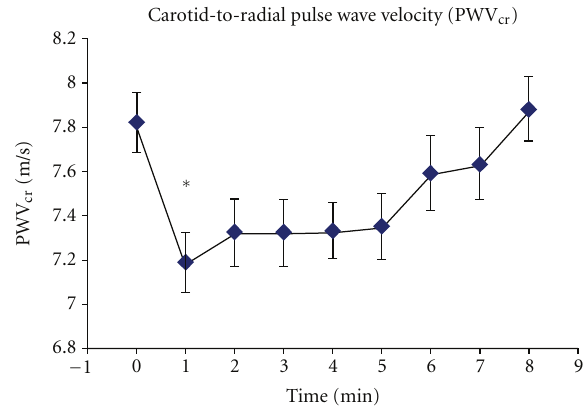
Figure 4: MV and SEM of SI temporal pattern measured at rest (baseline) and 8 minutes after cu ff deflation. ∗ indicates significance ( P < 0 . 05) comparing baseline to one minute after cu ff